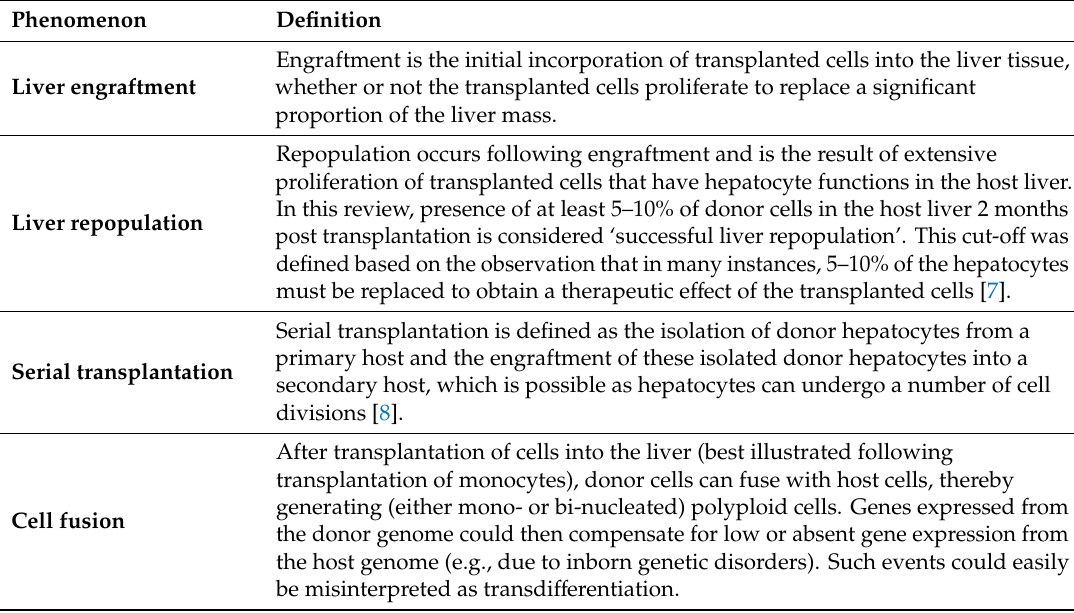
Table 1. Definitions of di ff erent e ff ects exerted by transplanted cell populations on the liver, used in this